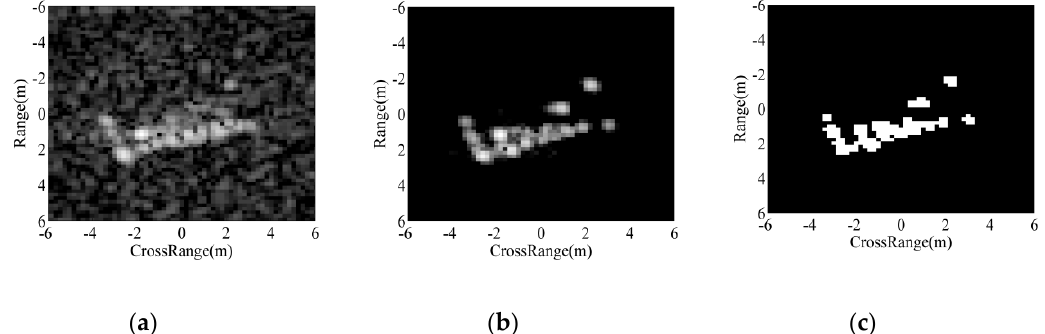
Figure 5. Illustration of ASC extraction and region prediction: ( a ) original image; ( b ) reconstructed image using ASCs; ( c ) overlap of all the predicted regions.